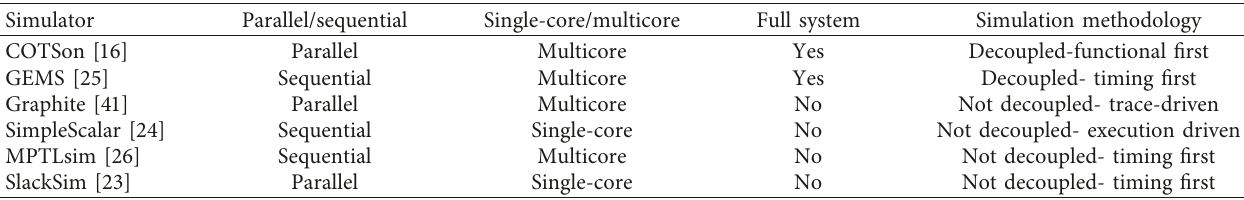
Table 2: Interesting features of simulators for high-performance computing architectures. For the nonobvious columns, Parallel/Sequential means the simulator core can be executed either in parallel or sequential by the host processor. Full System means taking into account all events, including the